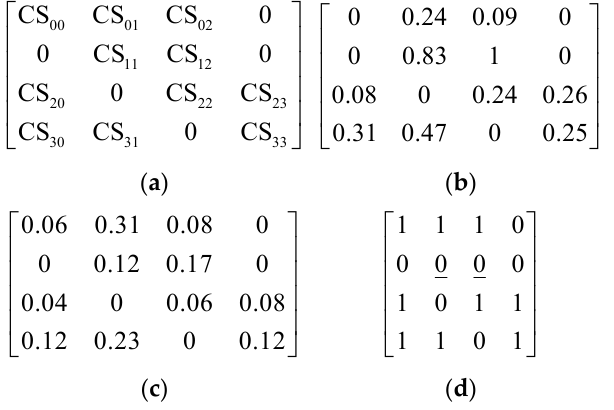
Figure 3. The provision, risk, benefit, and evaluation matrixes for the pharmacy CSC. ( a ) Provision matrix; ( b ) risk matrix; ( c ) benefit matrix; ( d ) evaluation matrix.